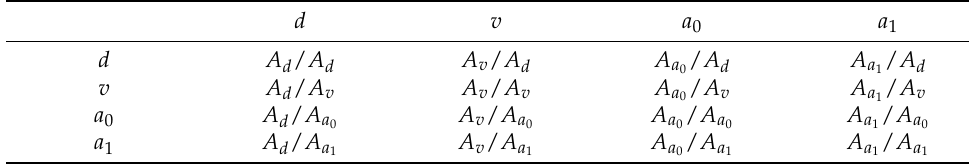
Table 2. Pairwise comparison matrix of multiple